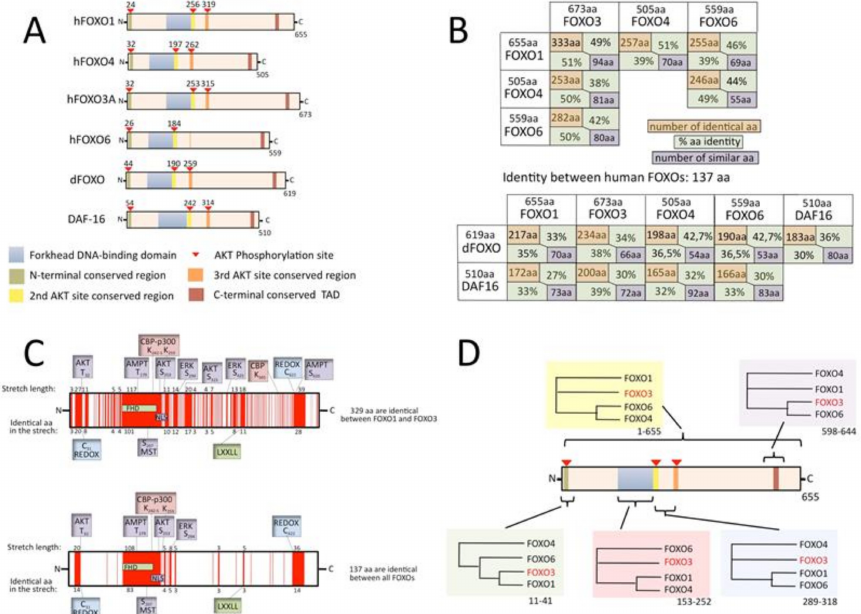
Figure 2. ( A ) Schematic representation of the four human FOXO members and their most important shared features; ( B ) identity in terms of amino acid number and percentage (related to each protein in the comparison) and number of similar amino acids. FOXOs are compared one to one (EMBOSS Needle, Matrix: EBLOSUM62, GAP penalty: 10.0, Extend penalty: 0.5 [33]). ( C ) Sequences that are identical in the two most similar proteins, FOXO1 and FOXO3 (top), and in all four human FOXOs (bottom) are depicted in red. ( D ) Phylogeny tree obtained with Clustal Omega when the indicated segments of the four human FOXO proteins are compared (the range of amino acid indicated below the boxes is relative to FOXO3